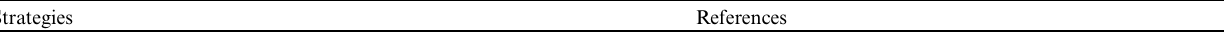
Table 1. Strategies of “successful” leadership as discussed in the environmental sciences literature. References refer to the cases reviewed in this